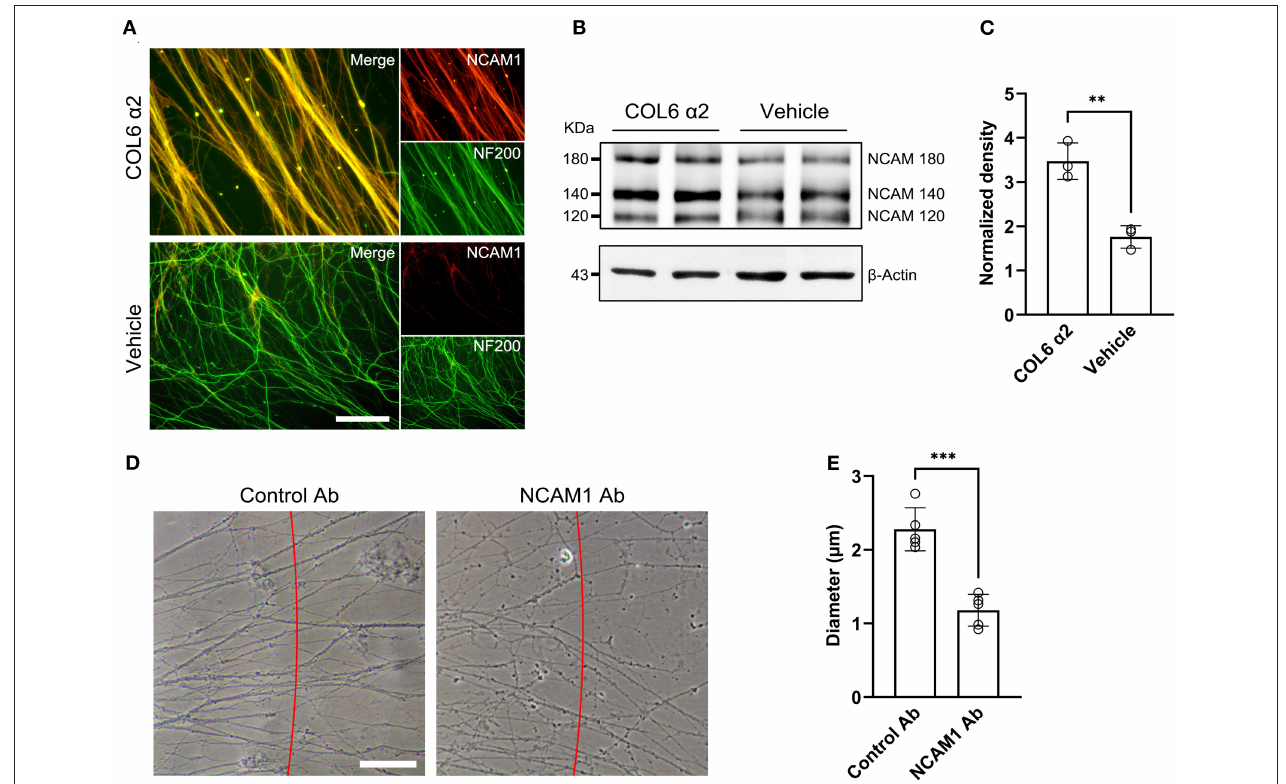
FIGURE 4 | COL6 α 2 promotes axonal clustering through the NCAM1-mediated pathway. (A) Representative immunofluorescence images showing the expression of NCAM1 (red) in axons (labeled with NF200, green). The fluorescence signal of NCAM1 was stronger in the COL6 α 2 group than in the vehicle group. (B) Immunoblotting exhibited the NCAM1 (NCAM120, NCAM140, and NCAM180) bands together with the β -actin bands in the COL6 α 2 and vehicle groups. (C) Histogram of the normalized density showing an upregulated NCAM1 expression in the COL6 α 2 group, compared with the vehicle group ( n = 3 independent experiments, ** p = 0.0036, unpaired t- test; the expression of NCAM1 was normalized to β -actin). (D) Microscopy of axon bundles growing on the COL6 α 2-coated substrate followed by control-antibody (GAPDH-Ab) or NCAM1-antibody blocking for 48h. The red line indicates a 500 µ m distance from the DRG tissue block. The diameter of each bundle across the red line was measured. (E) Histogram showing a significantly decreased axon bundle diameter with NCAM1-antibody treatment, compared with the control-antibody ( n = 5 independent biological experiments, *** p < 0.0001, unpaired t- test). Scale bar = 20 µ m in (A)